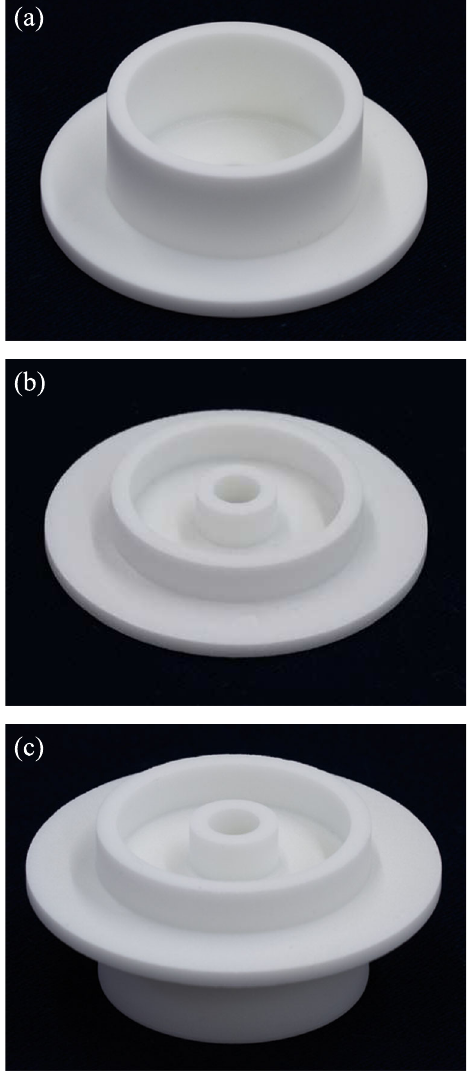
FIG. 5. The fabricated dielectric cell structures: (a) regular dielectric cell, (b) end dielectric cell, (c) hybrid dielectric